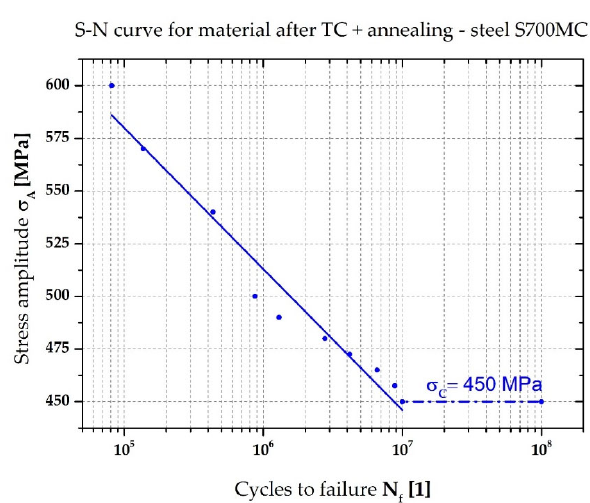
Figure 12. S–N curve of samples with residual stress and subsequent annealing at 550 °C for 2 h.